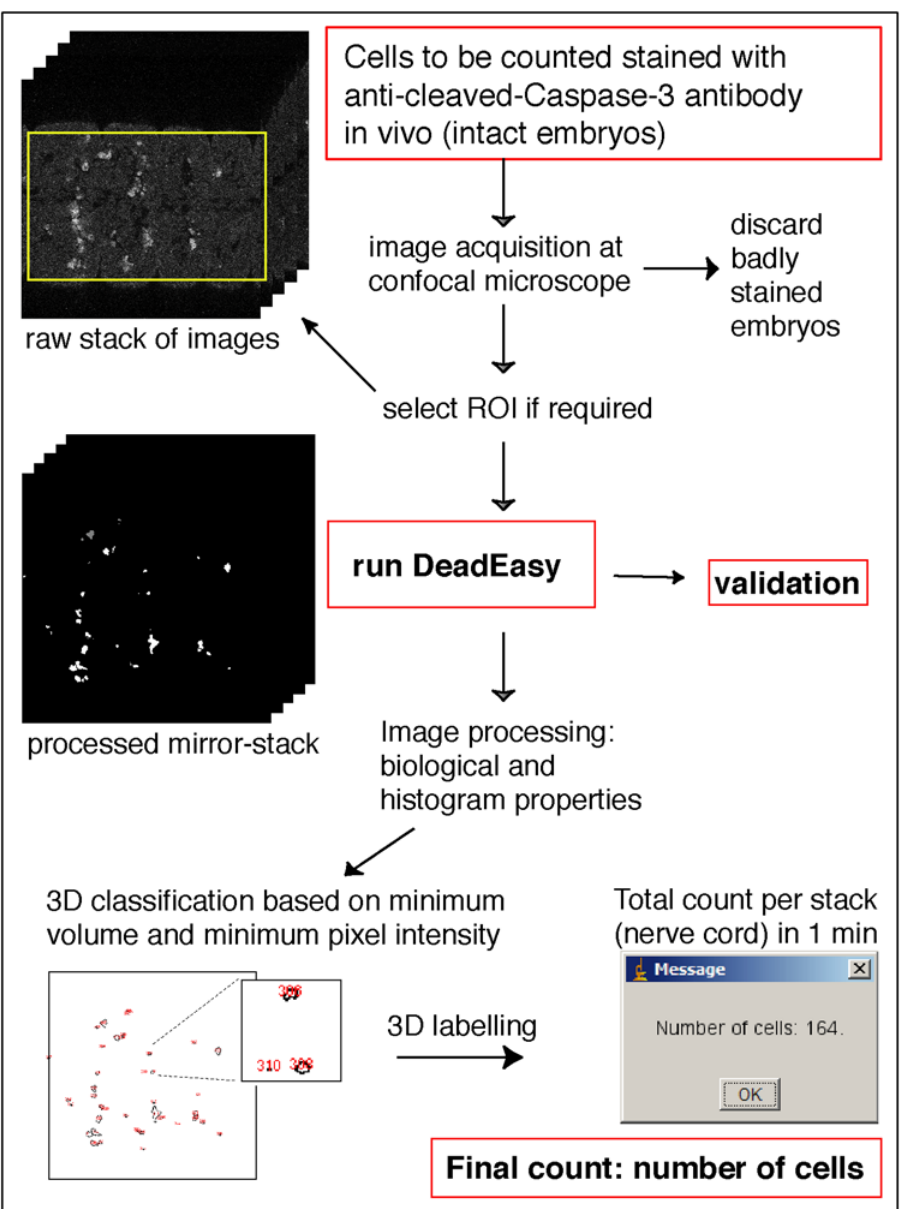
Figure 2. How DeadEasy software works. doi:10.1371/journal.pone.0005441.g002 grey level intensities are normally distributed, the Gaussian function G b (q) that best fits the shape of the embryonic mode is found. This is achieved by minimizing the square error between the histogram h ( q ) in the interval corresponding to the mode and G ( q ), that is: